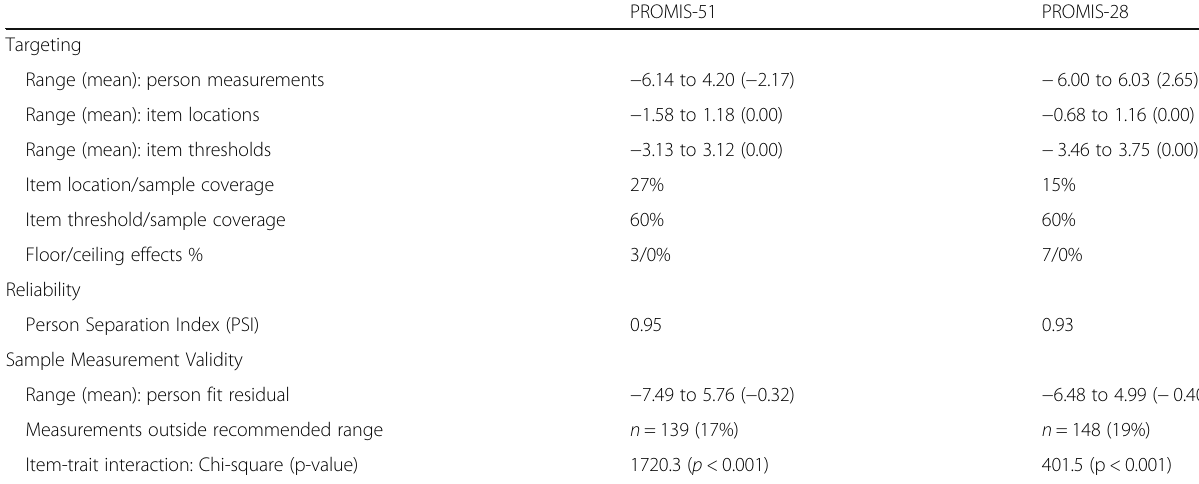
Table 1 Targeting, reliability and sample measurement